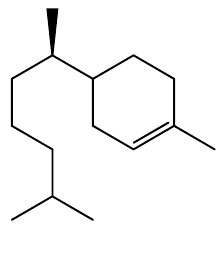
Figure 2. Tentative structure of